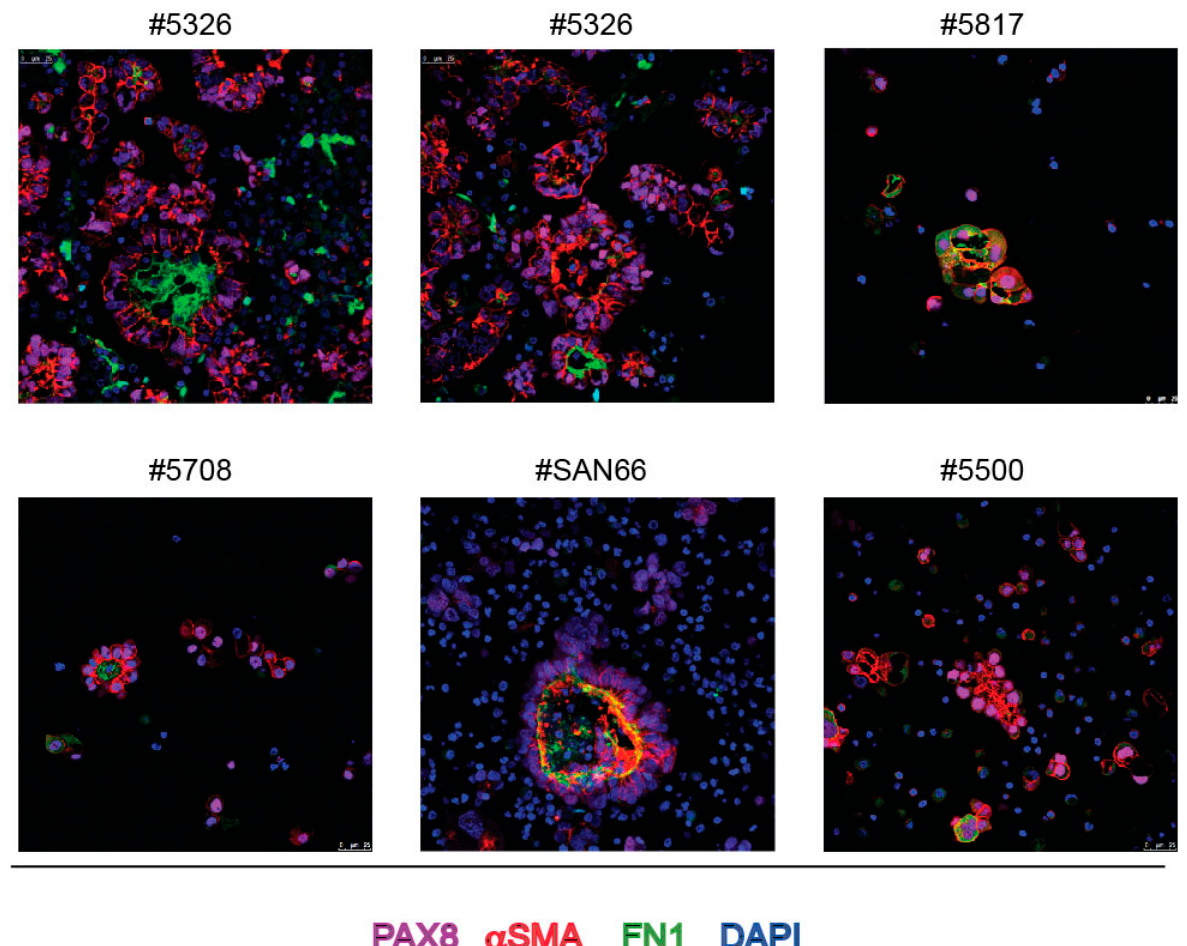
Figure 7. IF staining of spheroids from bulk ascites samples with FN1, PAX8 and α SMA MAbs and DAPI. Intracellular FN1 was detected in samples #5817 and #5500. Z-stack of images of samples #SAN66 is shown. Numbers on top of each panel correspond to the Profiling protocol numbers of the collected ascites. Details of each #case are in Supplementary Table S1.